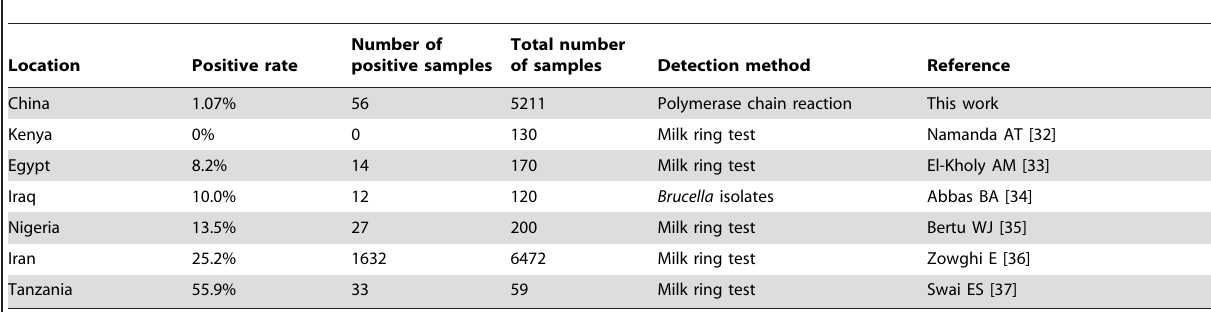
Table 1. Comparison of our results with those from other studies.